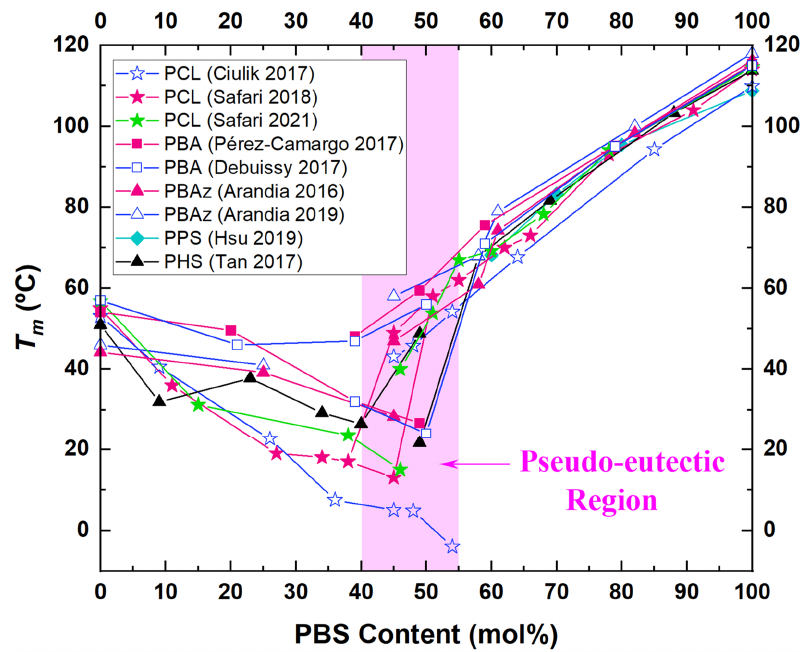
Figure 3. Variation of the melting temperature as a function of the PBS composition for selected copolyesters. Pseudo-eutectic points can be observed in the shaded region.